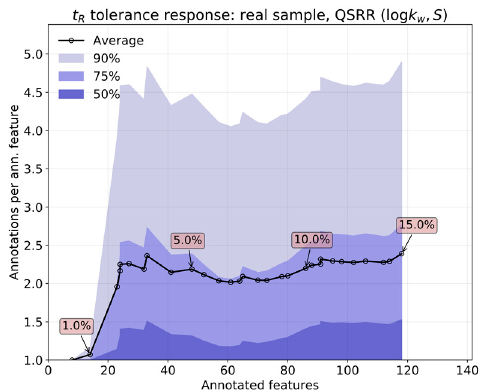
Figure 5. Annotation multiplicity (QSRR). Figure 6. Annotation multiplicity (Exp).